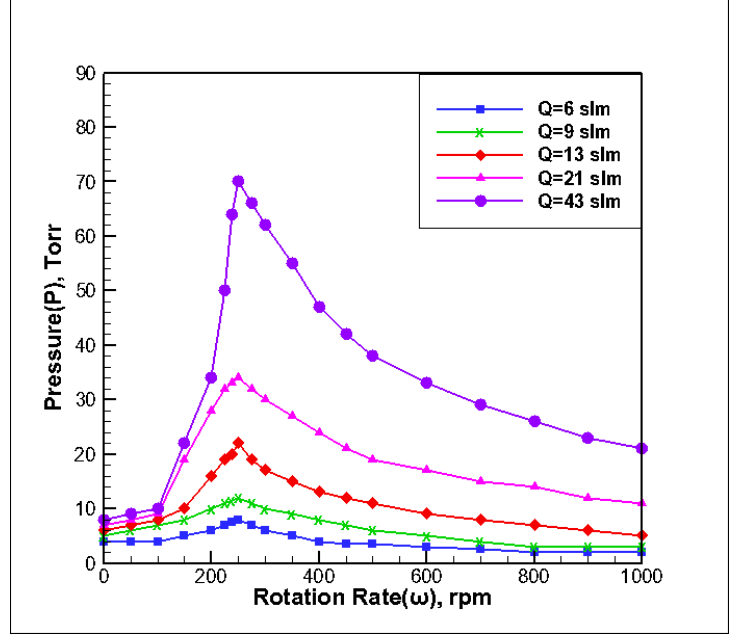
Figure 3. P- ω stability map under different inlet flow rates.